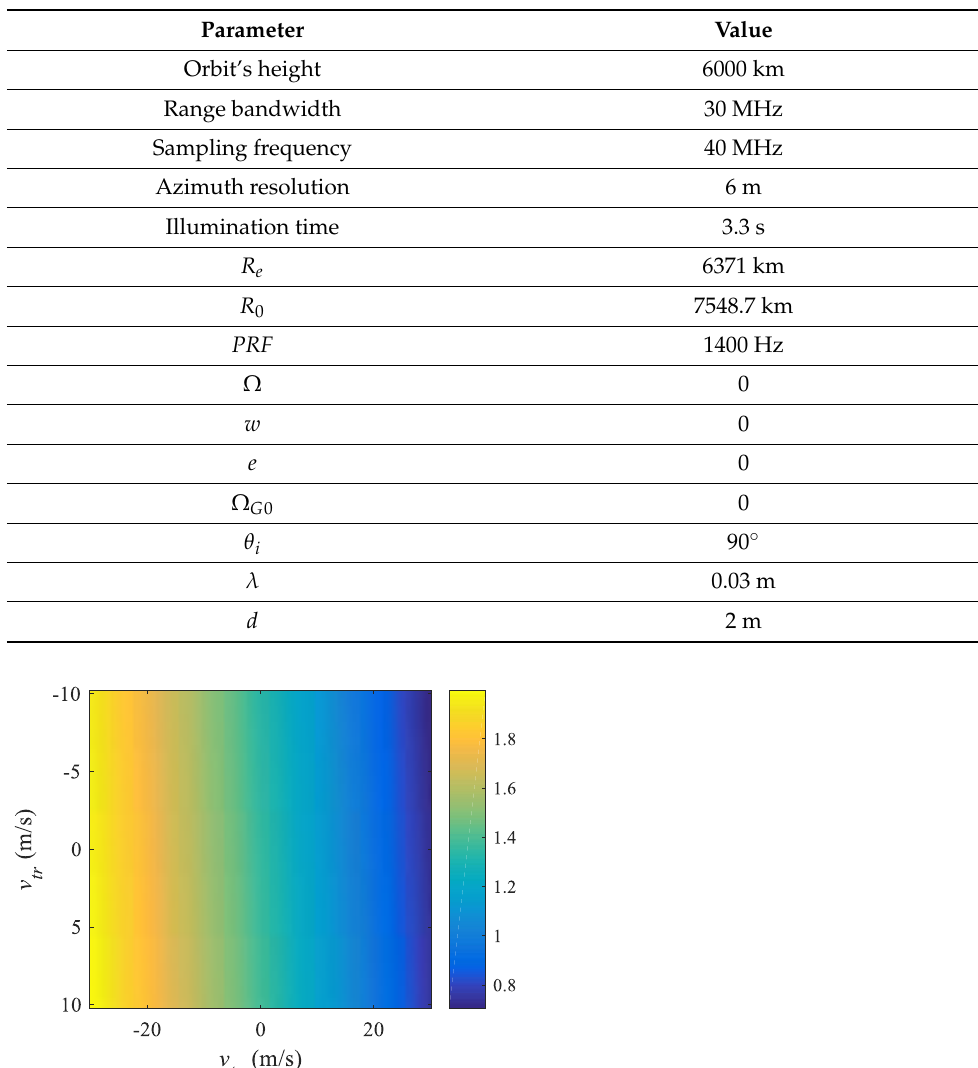
Table 1. Parameters of MEO SAR.